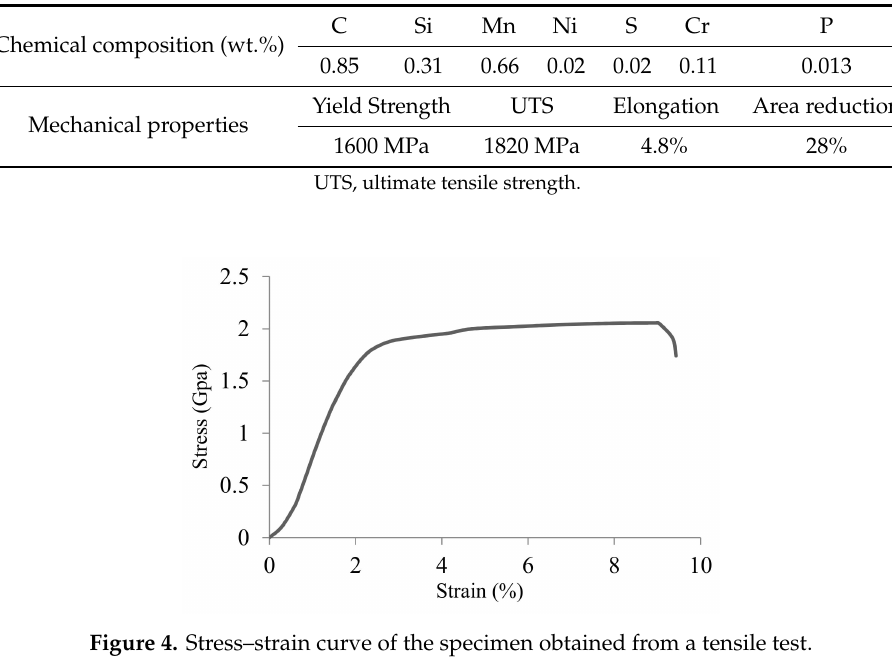
Table 2. Chemical composition and mechanical properties of the cable wire.